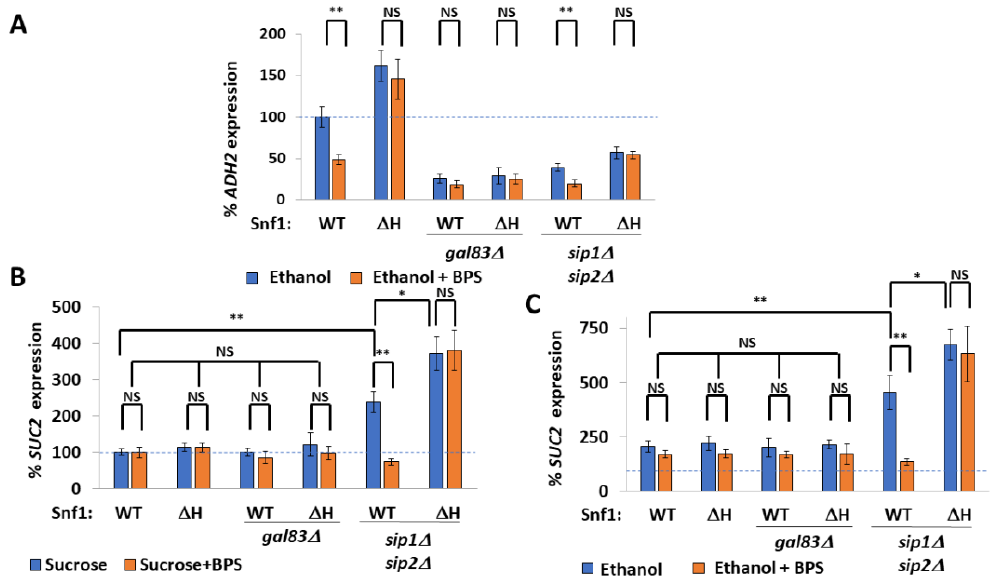
Figure 5. Temporal – spatial regulation of Snf1 by iron. ( A ) Rate of prADH2 ::LacZ expression when Snf1 is restricted to the cytoplasm ( gal83 Δ ) or to the nucleus ( sip1 Δ sip2 Δ ) upon iron chelation by 100 μM BPS. N = 3. Error bars are mean ±1 standard deviation. t -tests were performed as indicated. NS = not significant, * = p ≤ 0 .05, ** = p ≤ 0 .01. ( B , C ) Rate of prSUC2 ::LacZ expression when Snf1 is restricted to the cytoplasm ( gal83 Δ ) or to the nucleus ( sip1 Δ sip2 Δ ) upon iron chelation by 100 μM BPS: ( B ) is with sucrose as the carbon source, ( C ) is with ethanol (and is normalized to WT sucrose. N = 3. Error bars are mean ±1 standard deviation. t -tests were performed as indicated. NS = not significant, * = p ≤ 0 .05, ** = p ≤ 0 .01.